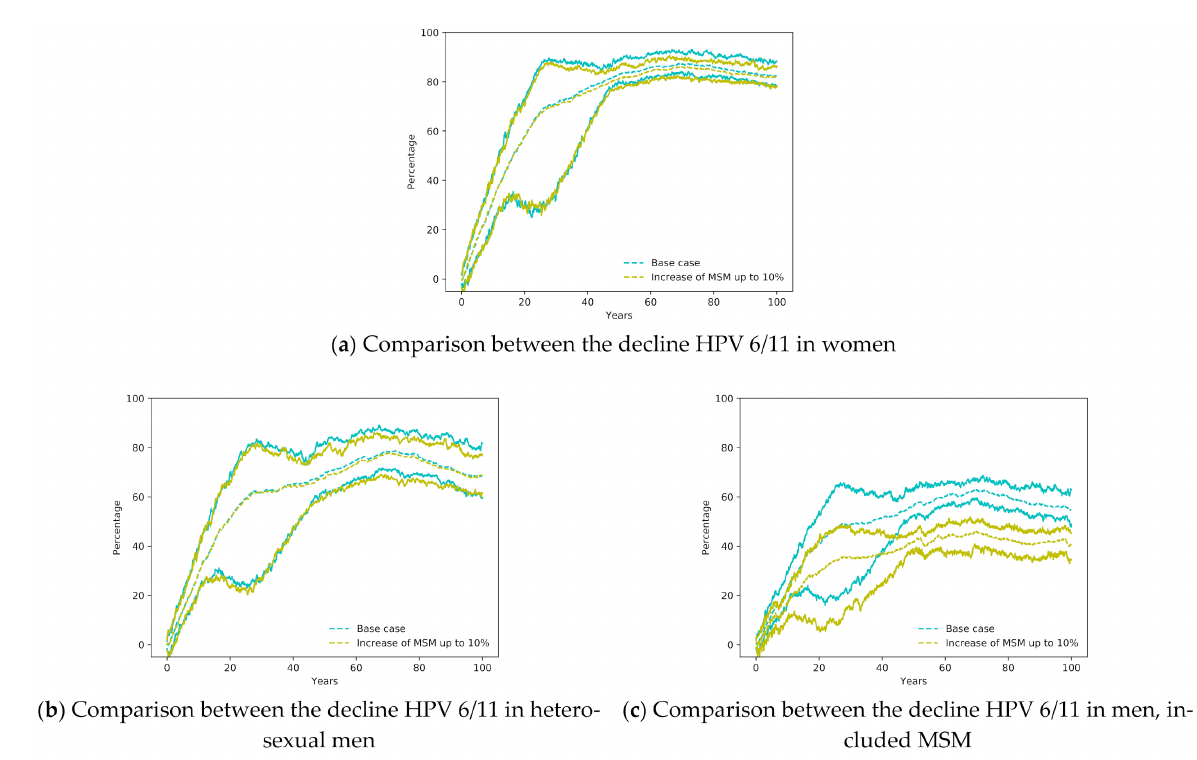
Figure 3. Comparison between the Base Case (vaccination of young girls with coverage 70% and 3.88% of MSM) with the same scenario with an increase of MSM up to